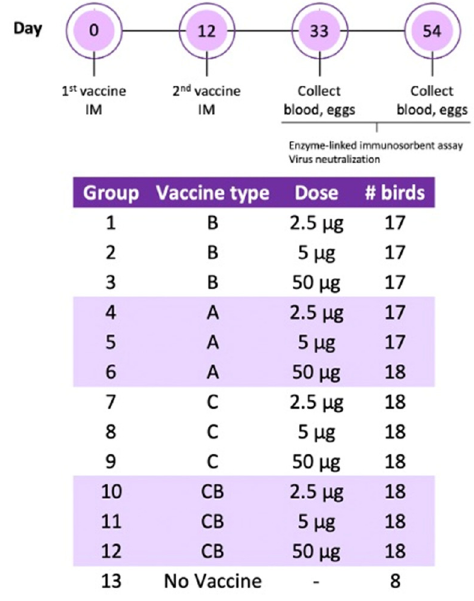
Figure 1. Schematic of the experimental design